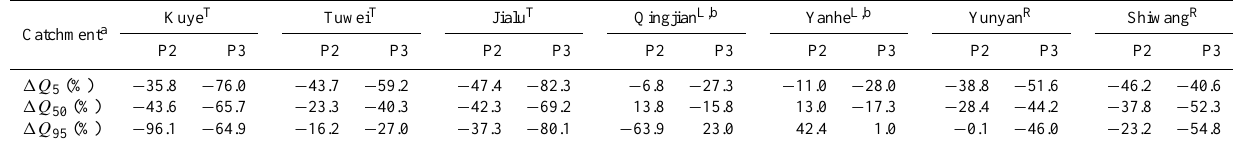
Table 4. The relative changes in high, median, and low flow regimes in period 2 and 3 compared to period 1 for the seven catchments. Kuye T Tuwei T Jialu T Catchment a